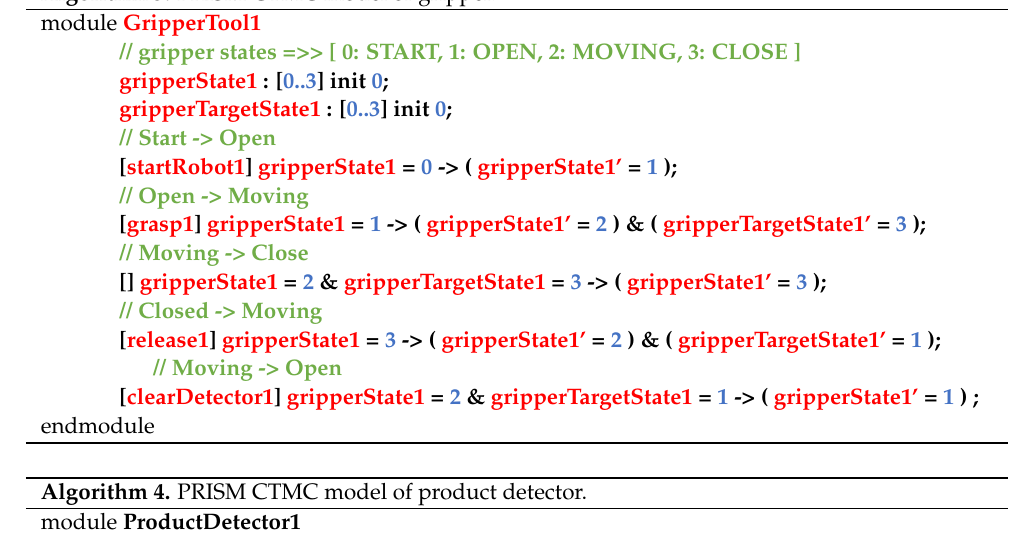
Algorithm 3. PRISM CTMC model of gripper.